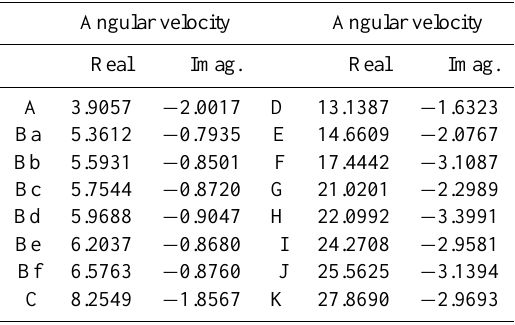
Table 3. Real and imaginary components of angular velocity (in ra- dians per day) for the gravity wave resonances and the major reso- nances found near the location of resonance B, calculated using the method described in the text. B is a single gravity wave resonance when the Coriolis term is zero but is mixed with nearby continental shelf wave modes when the Coriolis term has the correct